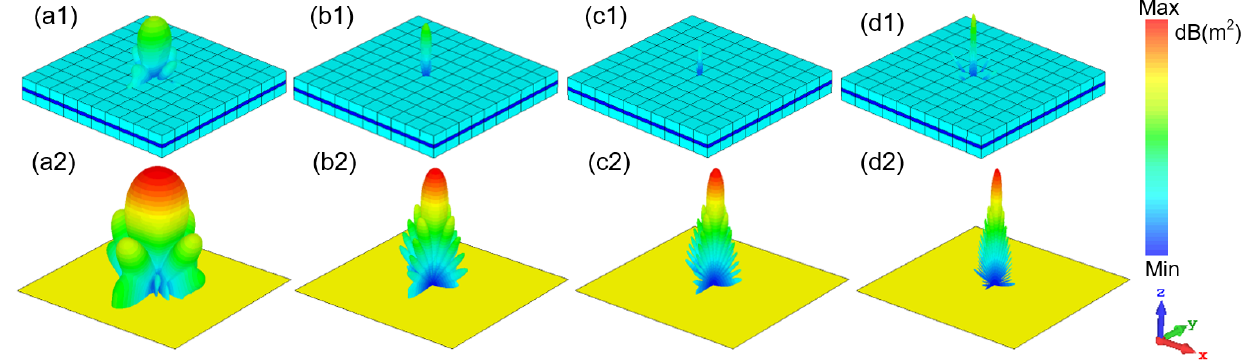
Figure 10. Figure 10. Full wave simulated scattering modes of the absorber and the metal plate at ( a1 , a2 ) 6.86 GHz; ( b1 , b2 ) 16.34 GHz; ( c1 , c2 ) 24.72 GHz; ( d1 , d2 ) 40 GHz.